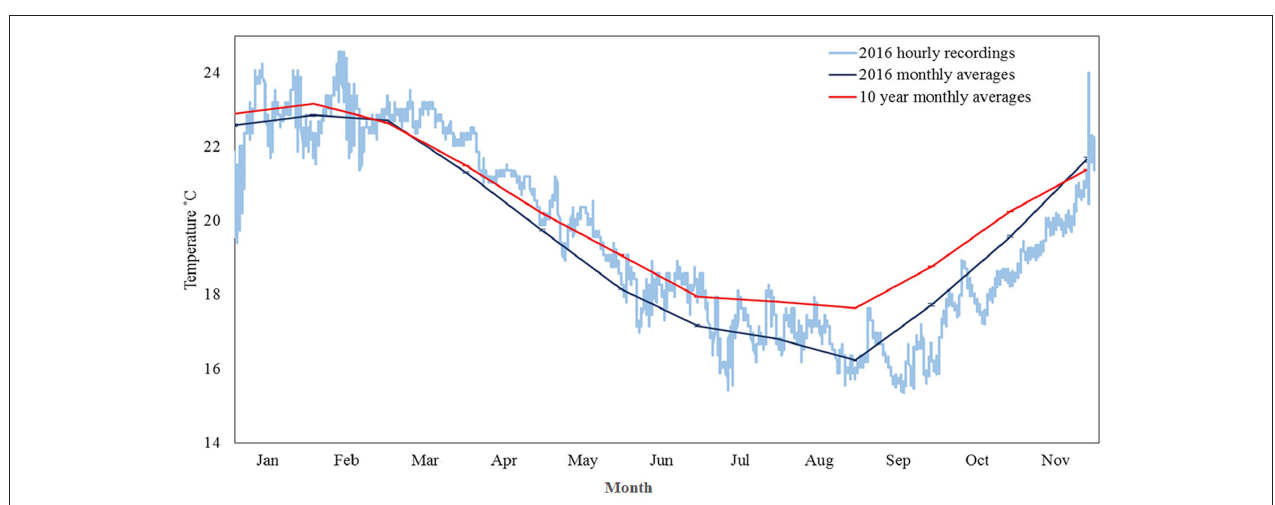
FIGURE 2 | In situ ( ± se) temperatures logged by an Onset Tidbit logger attached to a stake ∼ 5cm above the reef surface at Centaur Reef. Light blue line denotes hourly temperature records for 2016, dark blue line monthly temperature averages for 2016 and red line 10 year monthly (2006–2016) temperature averages.